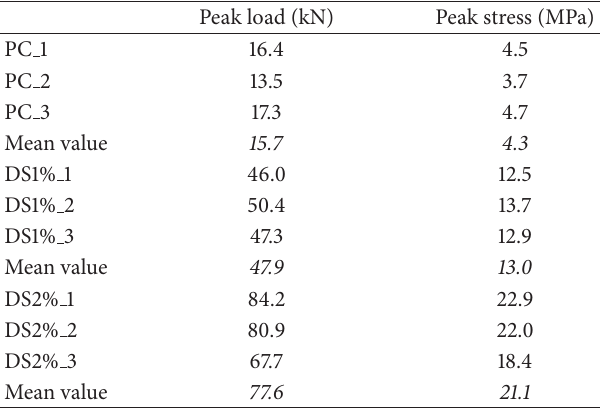
Table 4: Four-point bending tests: peak loads and corresponding stresses.